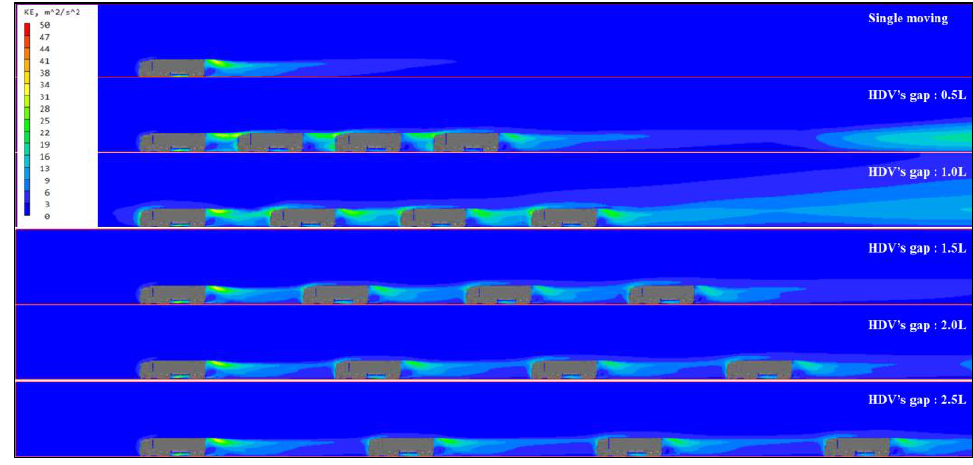
Figure 8. Comparison of the turbulent kinetic energy distribution with the change in the gap at 100 km/h.